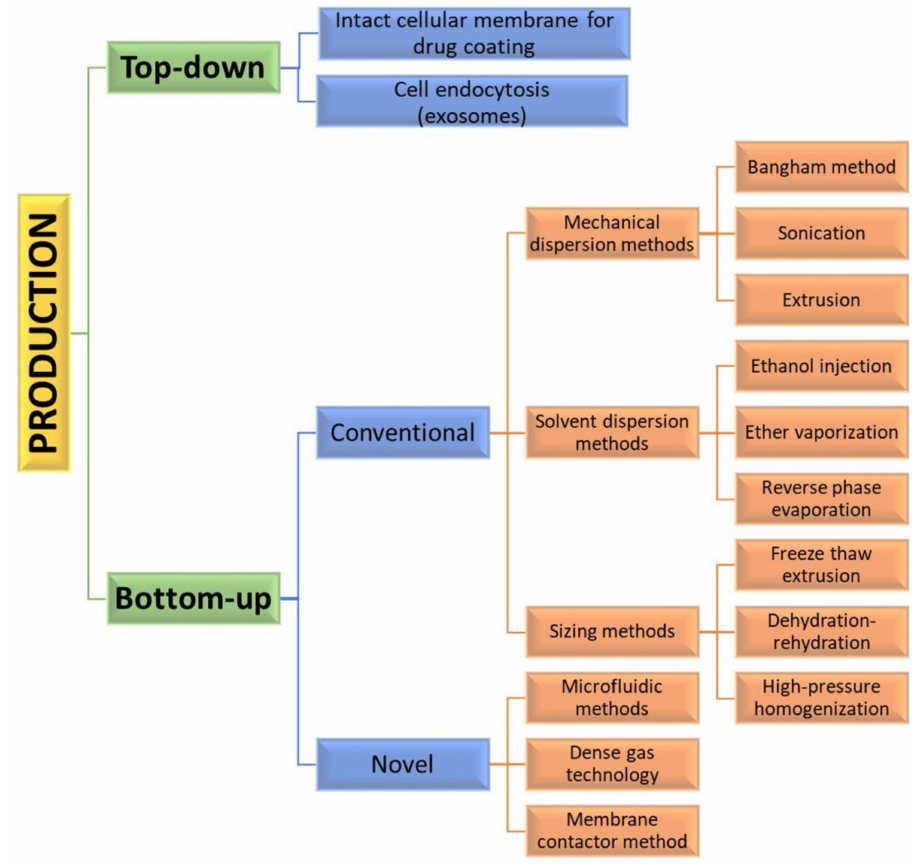
Figure 5. Diagram of various manufacturing engineering approaches and processes used for the synthesis of liposome